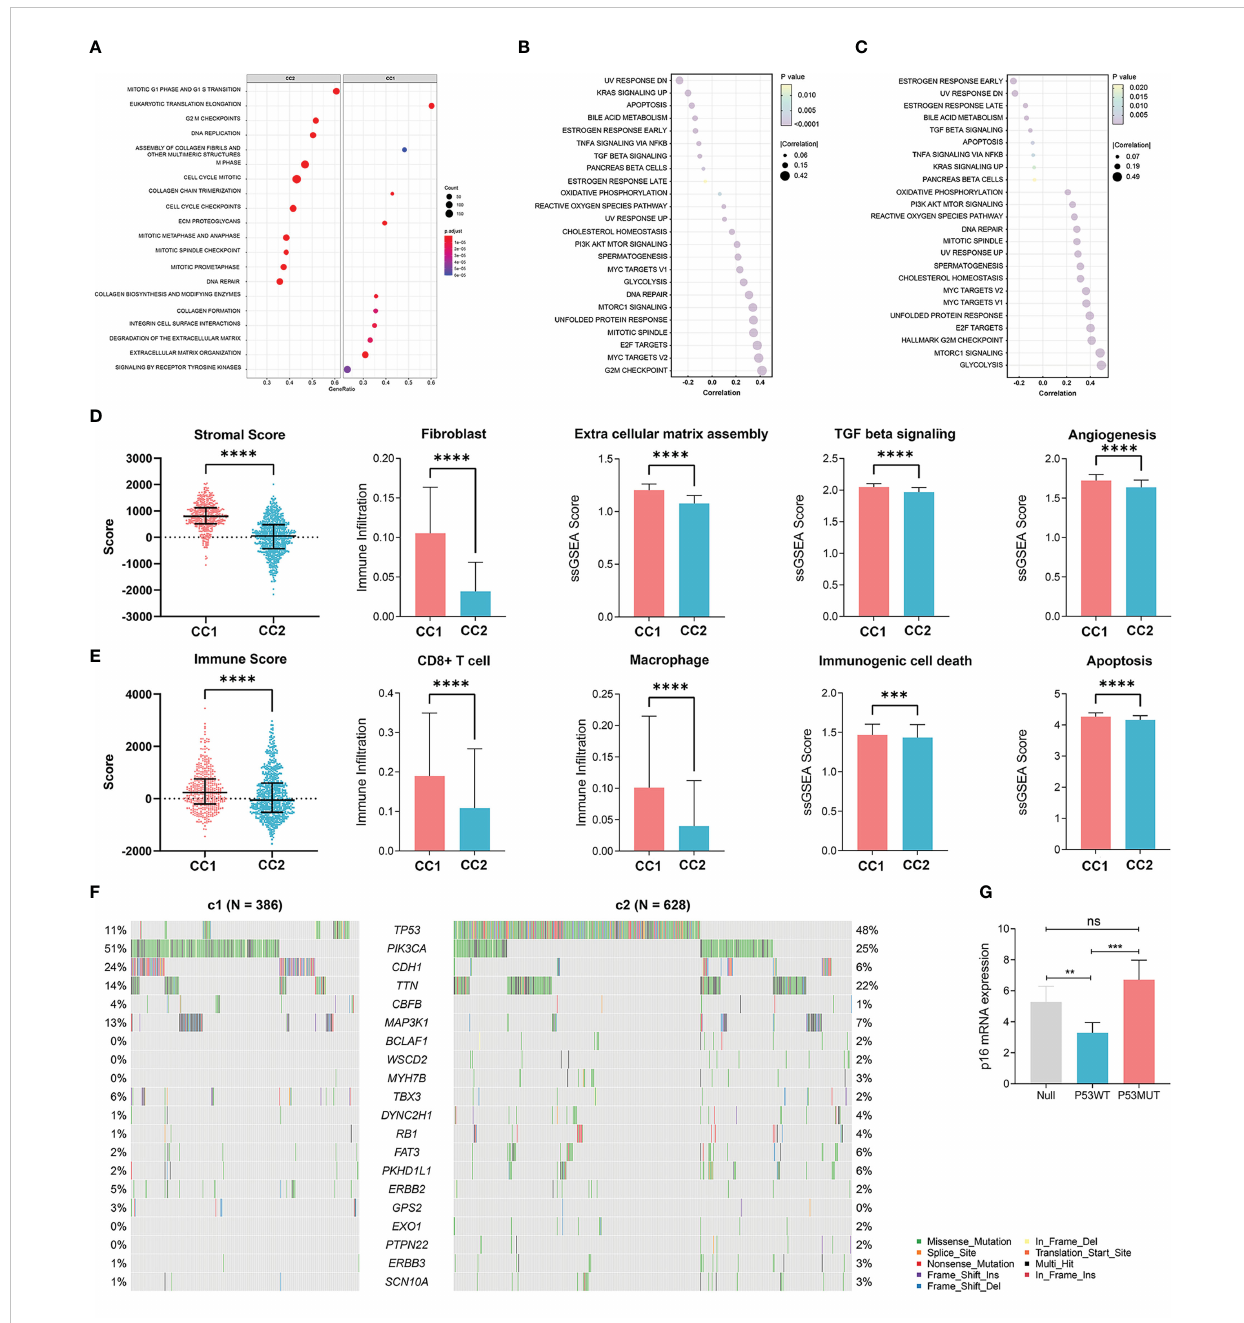
FIGURE 3 Elucidation of the biological impacts of senescence on the tumor biological process and the tumor microenvironment. (A) GSEA enrichment showing upregulated pathways in CC2 versus CC1. (B, C) The correlation between senescence and hallmark pathways of cancer in (B) TCGA-BRCA dataset and (C) the Metabric adtaset. (D) Comparison of stromal condition between CC1 and CC2, including stromal score calculated by Estimate, fi broblast cell number calculated by X cell, extracellular matrix assembly, TGF beta signaling, angiogenesis score calculated by ssGSEA. (E) Comparison of immune compartment between CC1 and CC2, including immune score calculated by Estimate, numbers of CD8 + T cells and macrophages calculated by Xcell, immunogenic cell death and apoptosis calculated by ssGSEA. (F) Comparison of mutation frequencies between CC1 and CC2 in the TCGA-BRCA dataset. (G) The effect of wildtype P53 (P53WT) and mutant P53 (P53MUT) re-expression on senescence in terms of p16 mRNA content measure by RT-qPCR in the P53 truncated cell line MDA-MB-436 **p < 0.01, ***p < 0.001, ****p < 0.0001. ns, no signi fi